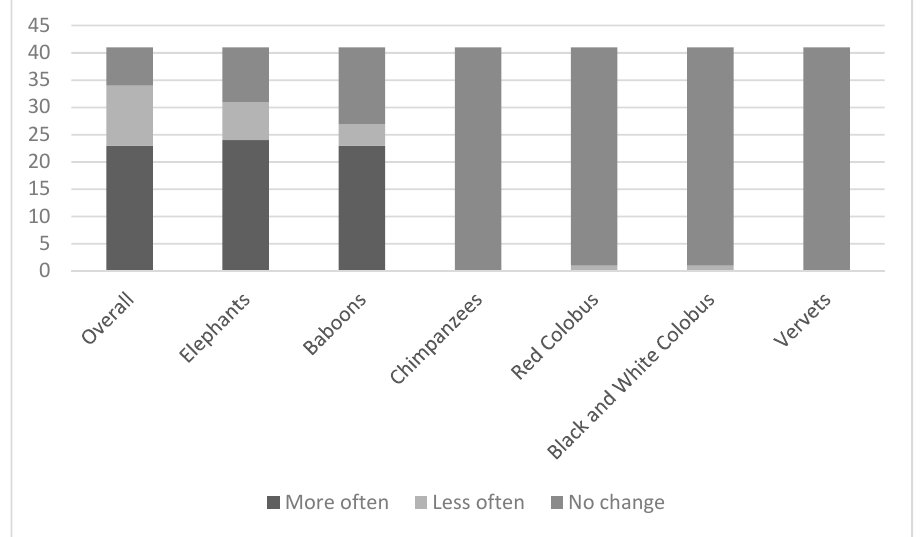
Figure 5. Reported changes in crop raiding patterns according to respondents from the participating communities (n = 93).